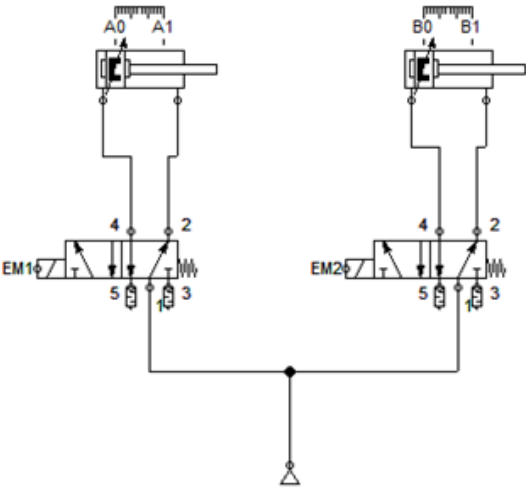
Figure 9. Principle schematics of testing.